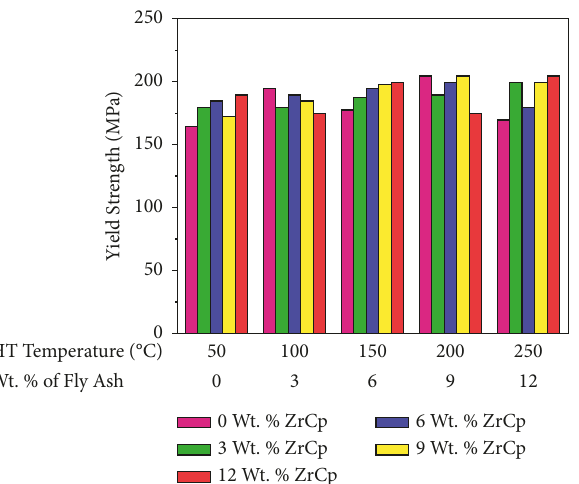
Figure 3: Yield strength for different experimental